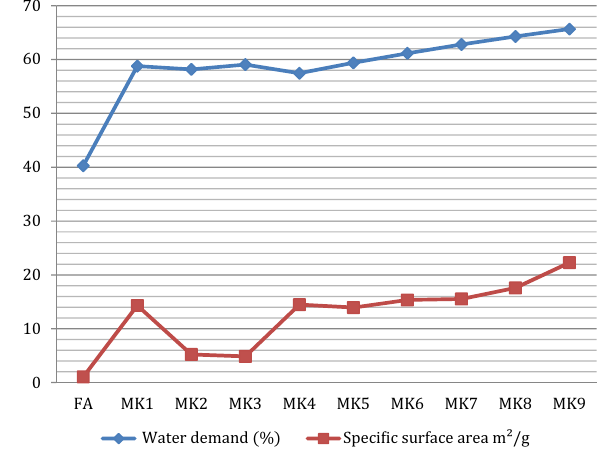
Fig. 2 Results of water demand and specific surface area for all the types of raw